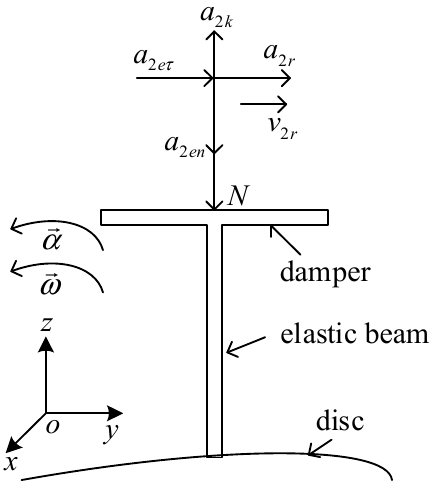
Figure 3. Acceleration synthesis and the normal load diagram of the damper.